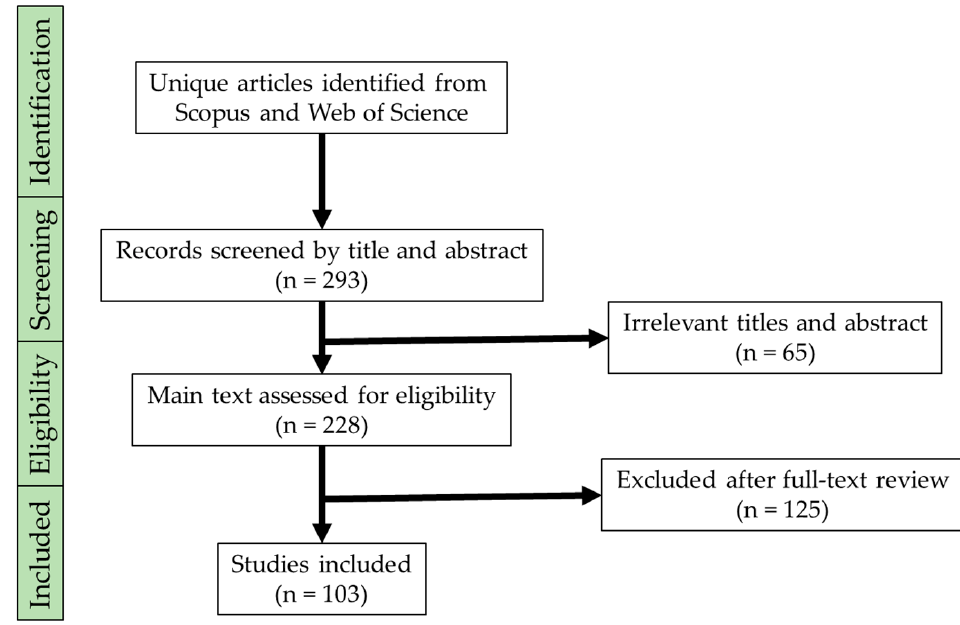
Figure 1. A PRISMA flowchart summarizing the search process.